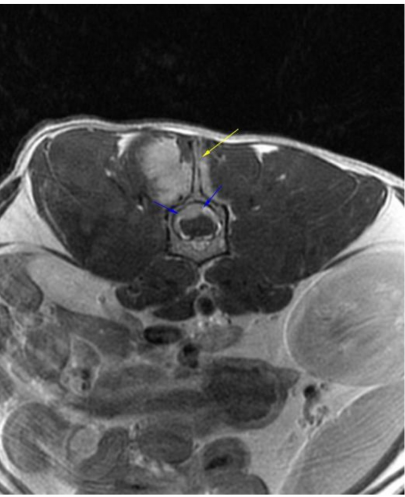
Figure 2. Post-contrast transverse T1W image showing contrast enhancement, thinning, and irregu- larity of the spinous process (yellow arrow) and dorsal lamina of L2 together with the invasion of the vertebral canal by the mass (blue